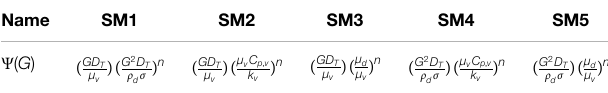
TABLE 2 | Information of the scaling methods optimizing